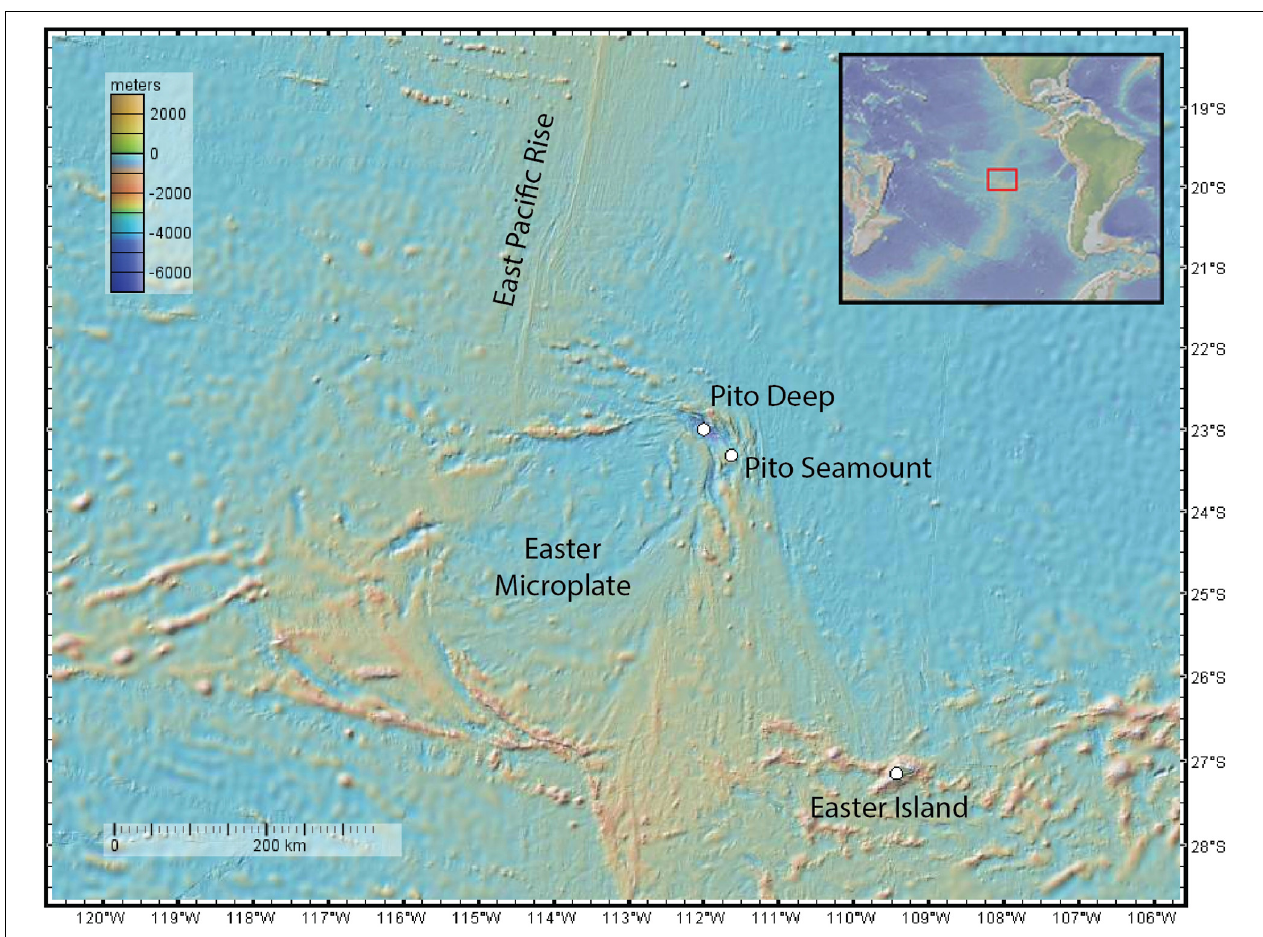
FIGURE 1 | Study locations: Pito Seamount, Pito Deep. GeoMapApp